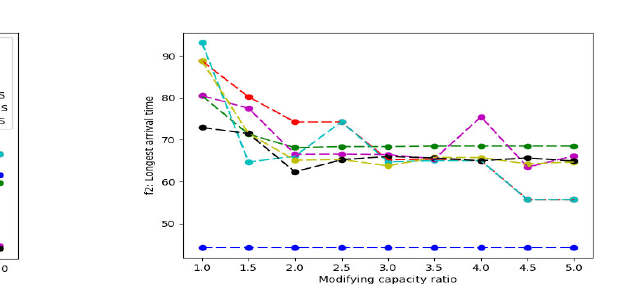
Fig. 7. The impact of capacity on 𝒇